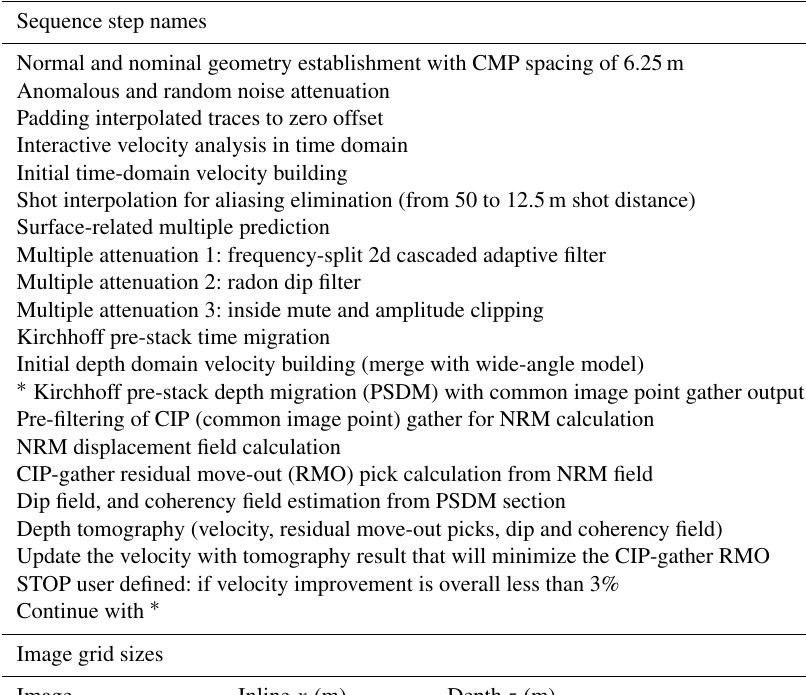
Table 1. Seismic processing sequences and image grid sizes.